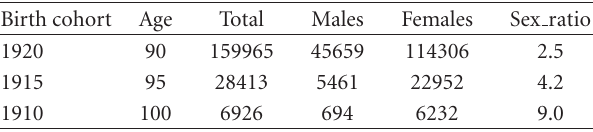
Table 1: Breakdown of the French population by sex and age, by January 1st